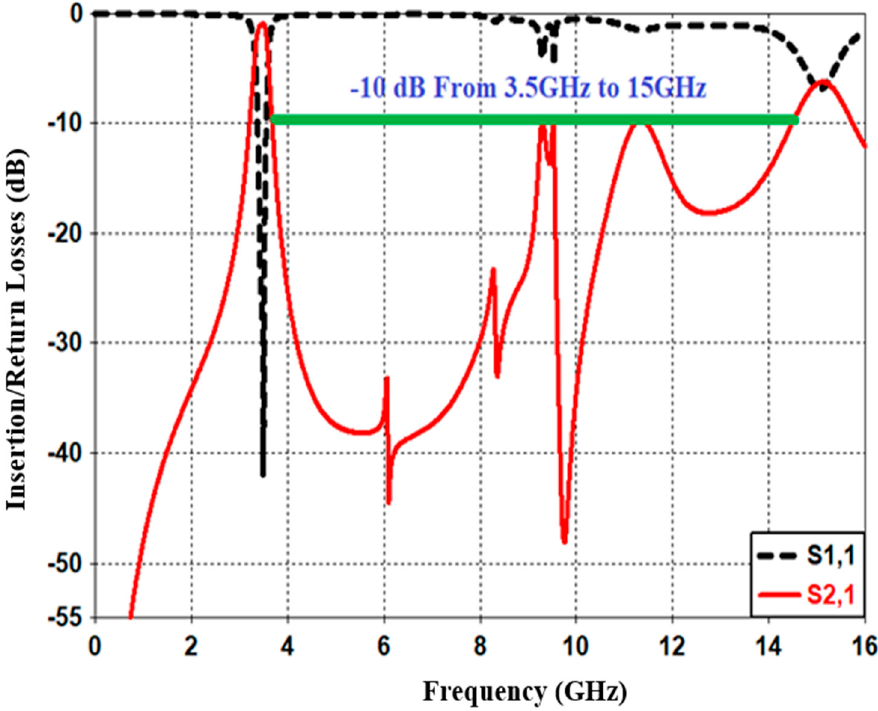
Figure 16. Simulated wide-band s-parameter characteristics for the presented reconfigurable microstrip BPF. Sensors 2020 , 20 , x